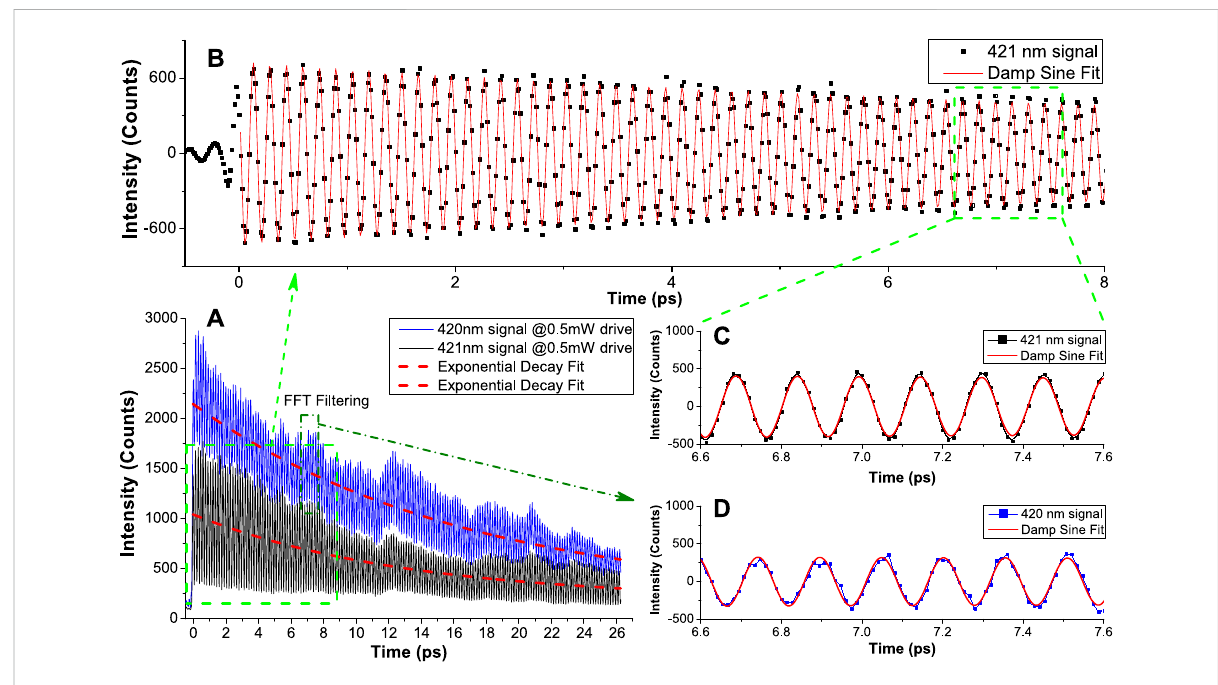
FIGURE 2 Experimental data with fi tted functions. (A) Long-range scanned data with a time resolution of 0.0133 ps. Solid lines represent the measured data, and dashed red lines are fi tted exponential decay curves. The fi tted curves give an average decay time of 16.14 ps. (B) Fast Fourier transform (FFT) fi ltered421 nmdata(blackdots) fi ttedtoadampedsinecurve(redline)ina10 pstimewindow.TheDCoffsetisremovedbytheFFT fi ltering. (C) Zoomed-in window as shown in the green dashed box. (D) Data of 420 nm signal (blue dot and line) and fi tted damped sine curve (red line) in the same time window as (C)